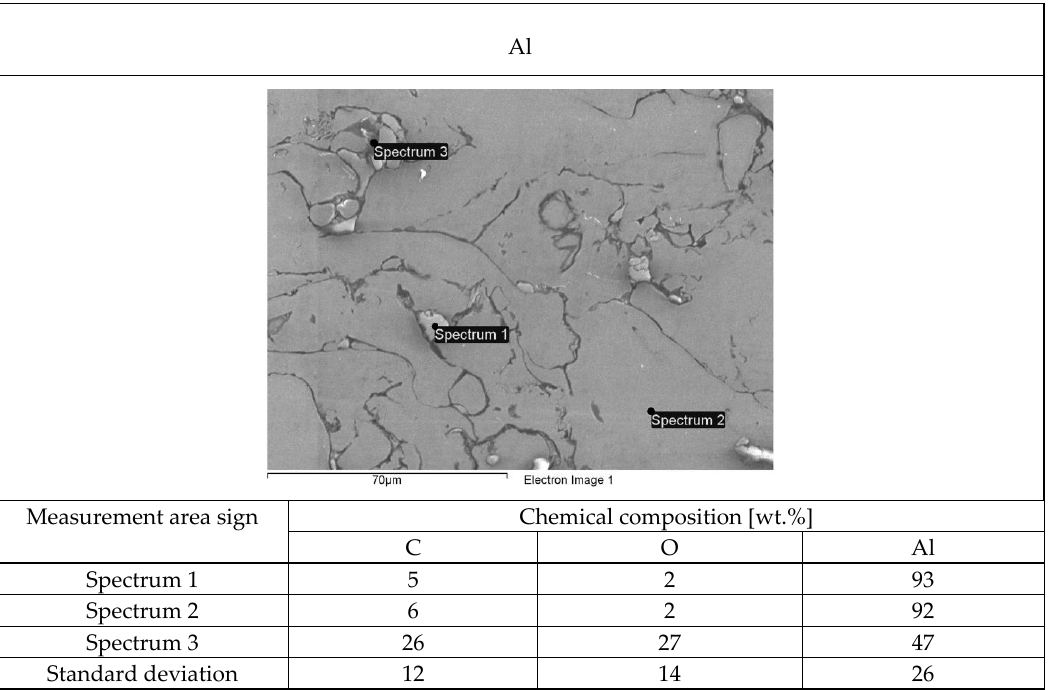
Figure 6 . The structure of EN AW 1000 aluminum powder flame-sprayed coating with marked chemical composition tested areas on SEM .